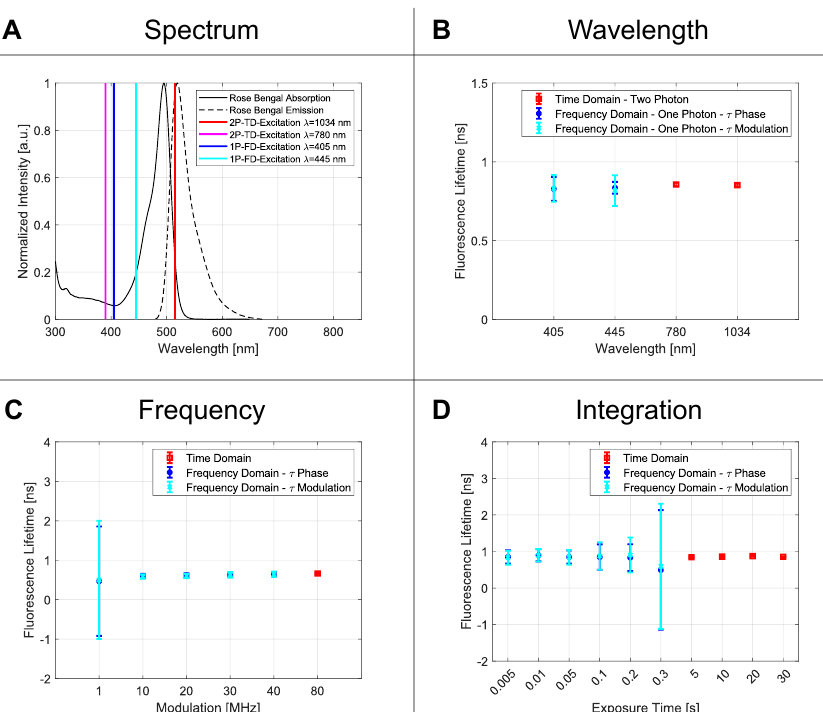
Figure 1. In ( A ), the absorption and emission spectrum of rose bengal and the individual excitation wavelengths are shown. The blue (405 nm) and cyan line (445 nm) represent the FD Wavelengths. For TD FLIM, the two-photon excitation wavelengths are shown in pink (two-photon excitation at 390 nm) and red (two-photon excitation at 515 nm). Although the laser lines are only slightly within the absorption spectrum, a sufficiently high fluorescence can be generated. In ( B ), the obtained fluorescence lifetimes for the wavelength dependency measurements were presented. In blue (phase lifetime) and cyan (demodulation lifetime), the results for the FD are shown, and in red the results for the TD are shown. In section ( C ), the influence of the repetition rate (TD) and the modulation frequency (FD) are shown. For the FD, the tangential relationship leads to inaccurate results for small modulation frequencies for lifetimes in the range of 1–10 ns. As the last parameter, the time constant for the different measurement methods is illustrated in ( D ). For the FD FLIM, high exposure times lead to pixel saturation and therefore creates bigger standard deviations. For the TD, the correlation is inverse. For longer integration times, a smaller error bar is detected due to the larger number of photons that form the decay